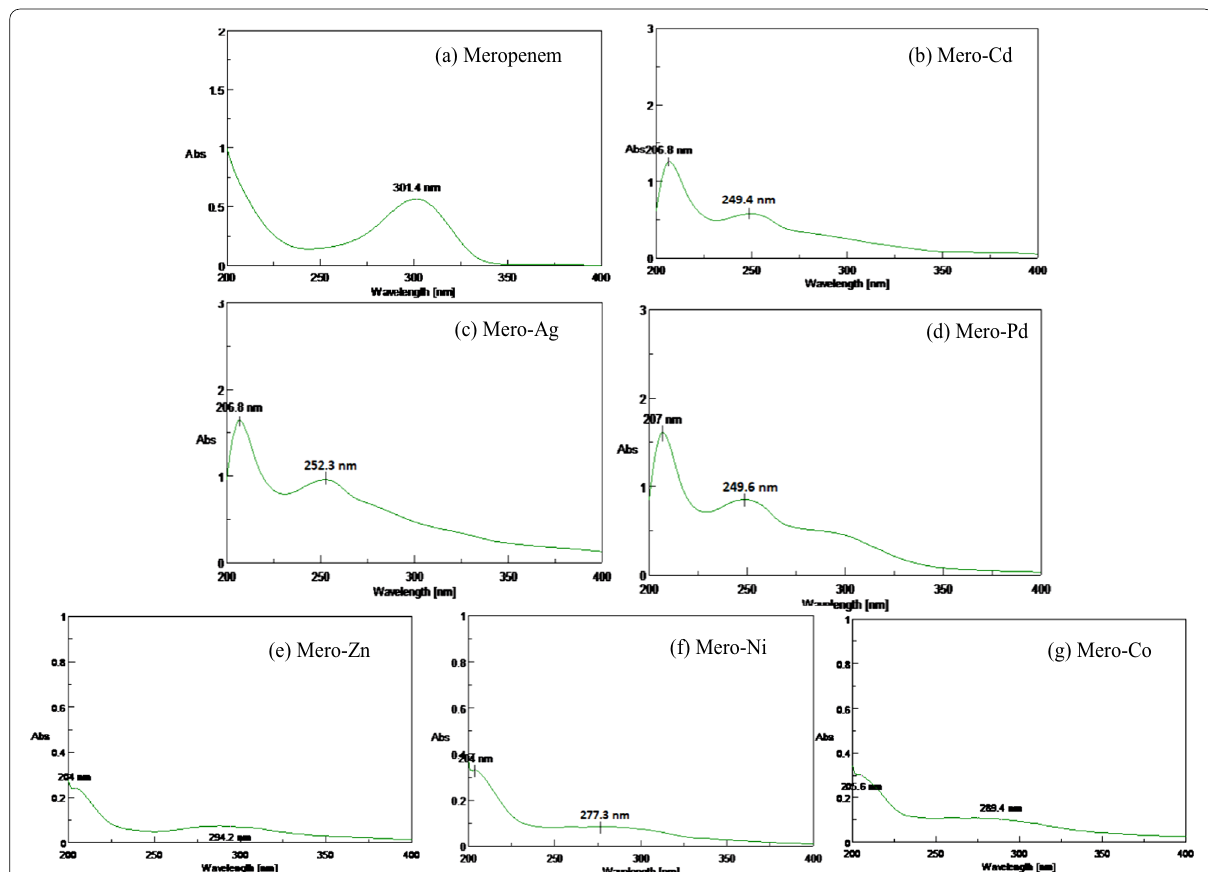
Fig. 1 UV spectrum in methanol a Meropenem, b Mero-Cd, c Mero-Ag, d Mero-Pd, e Mero-Zn, f Mero-Ni and g